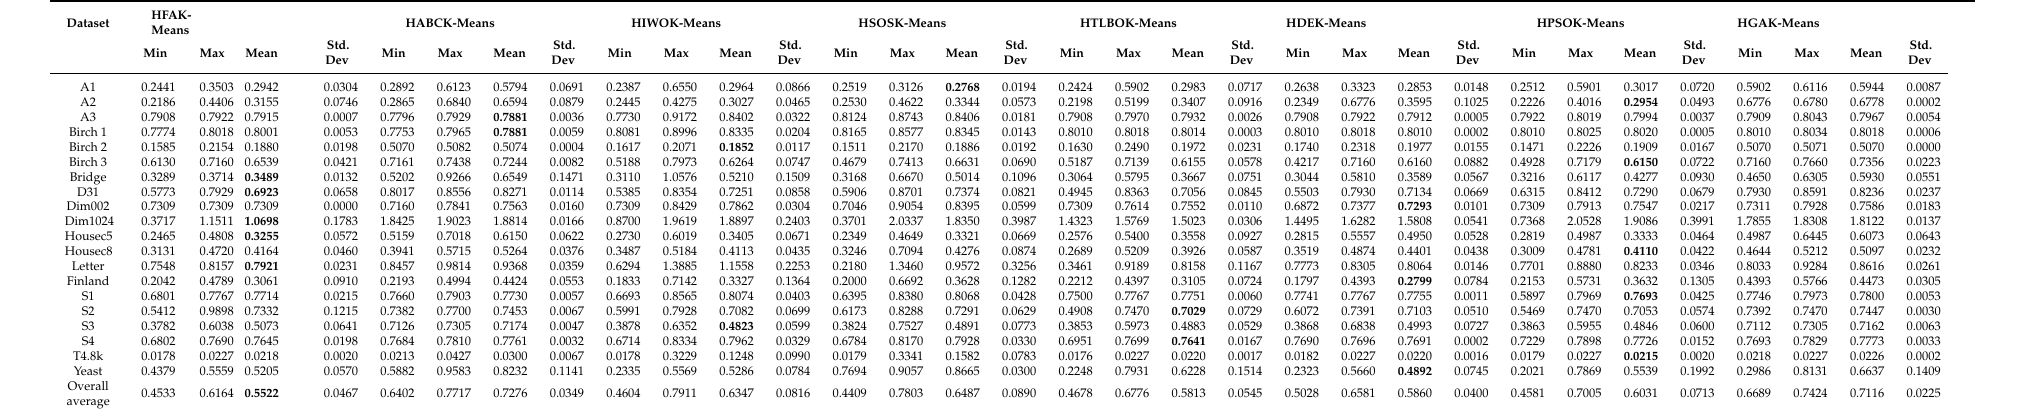
Table 3. Computation results for Improved FA-K-means and other seven metaheuristic-based K-means hybrid algorithms on twenty high-dimensional